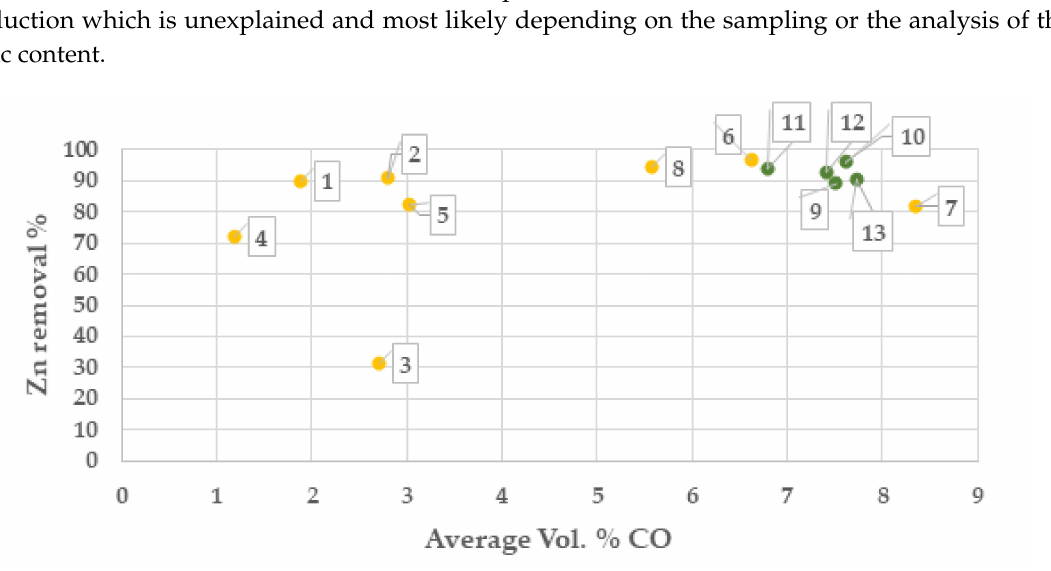
Figure 5. Zinc separation degree (%) at average Vol. % CO in OXYFINES reactor gas analysis (campaign 1, yellow colour and campaign 2 green colour). Points in chart are presented with index number for the respective batch.